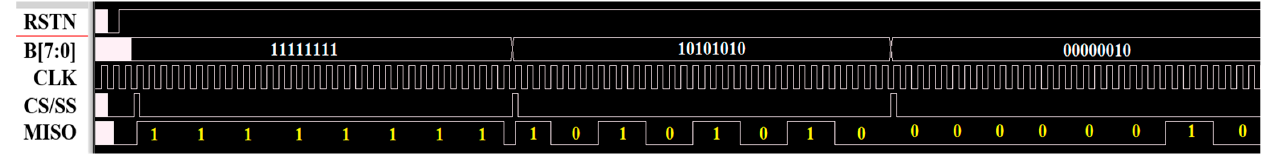
Figure 16. The layout of the flash ADC. The post-layout simulation result of the ADC is partially demonstrated in Figure 17. The output here varies from 56 to 76 as expected.